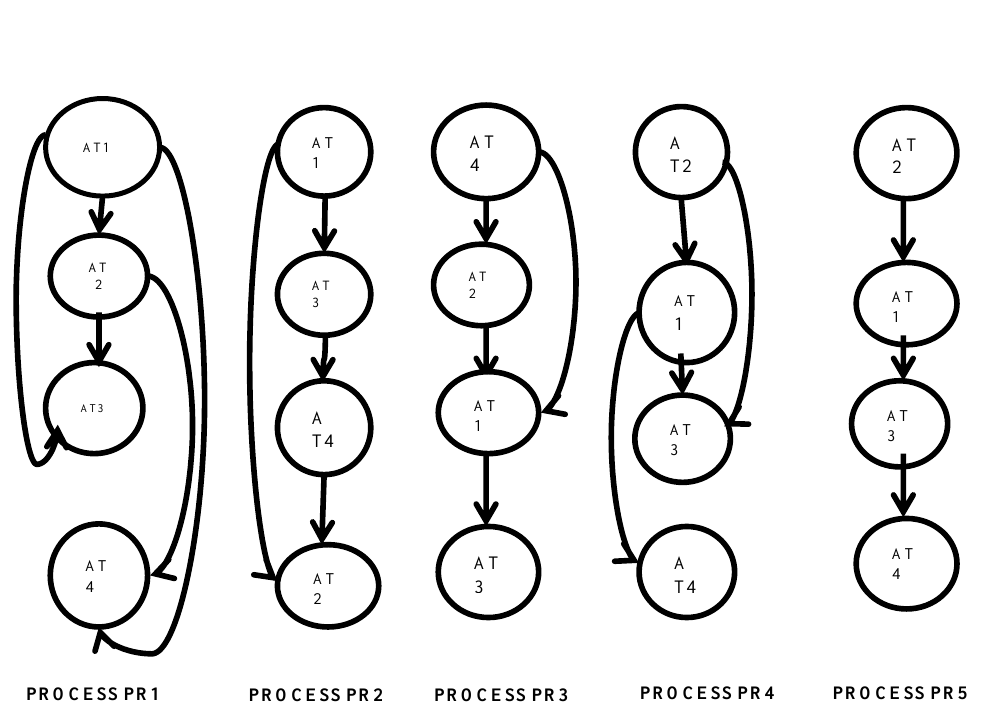
Figure 4. Dominance system graph to check the validity of pair wise comparison of actions with reference to various